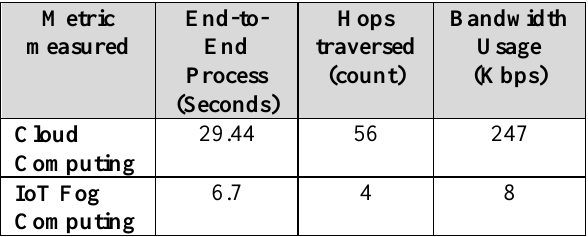
Figure 7. Fog and Cloud Bandwidth Usage Comparison